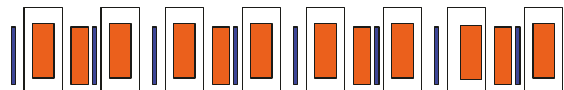
Figure 19: Structure of aperture antenna